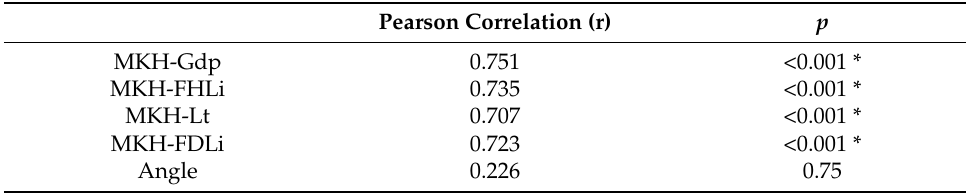
Table 3. Correlation of foot length with the length and angle parameters. Pearson Correlation (r) p MKH-Gdp 0.751 <0.001